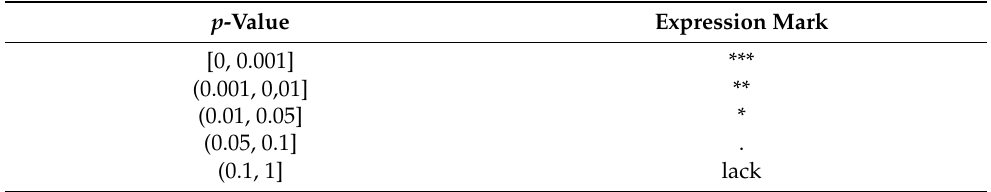
Table 6. The adopted markings of the p -value [20].